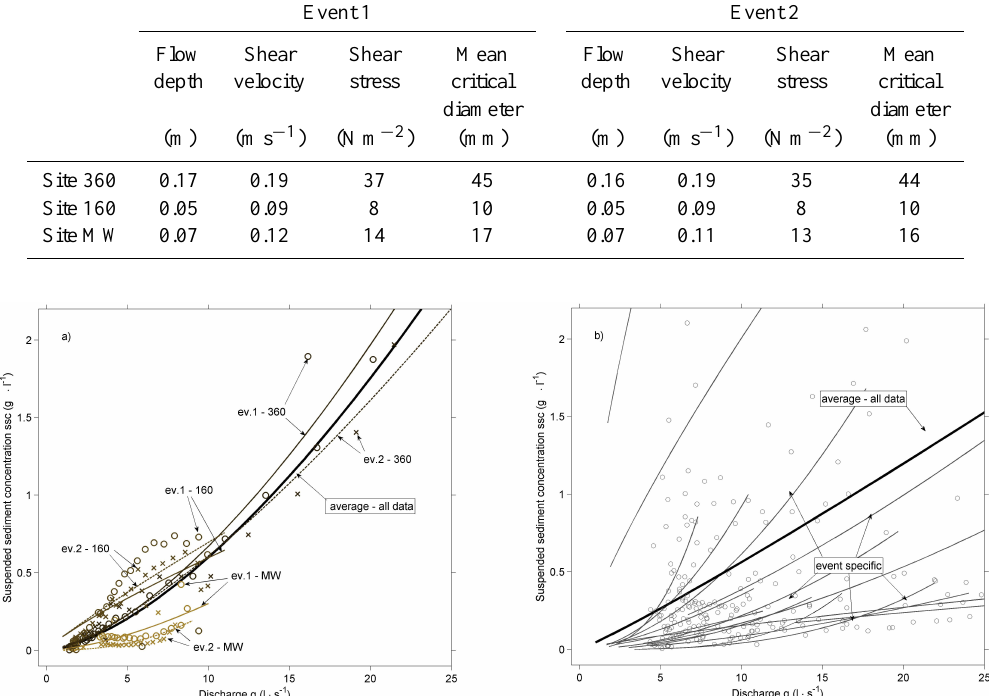
Fig. 10. Relationship between sediment concentrations and discharge of the flooding experiments (a) and natural events ( (b) , modified from Eder et al., 2010) in the HOAL catchment.